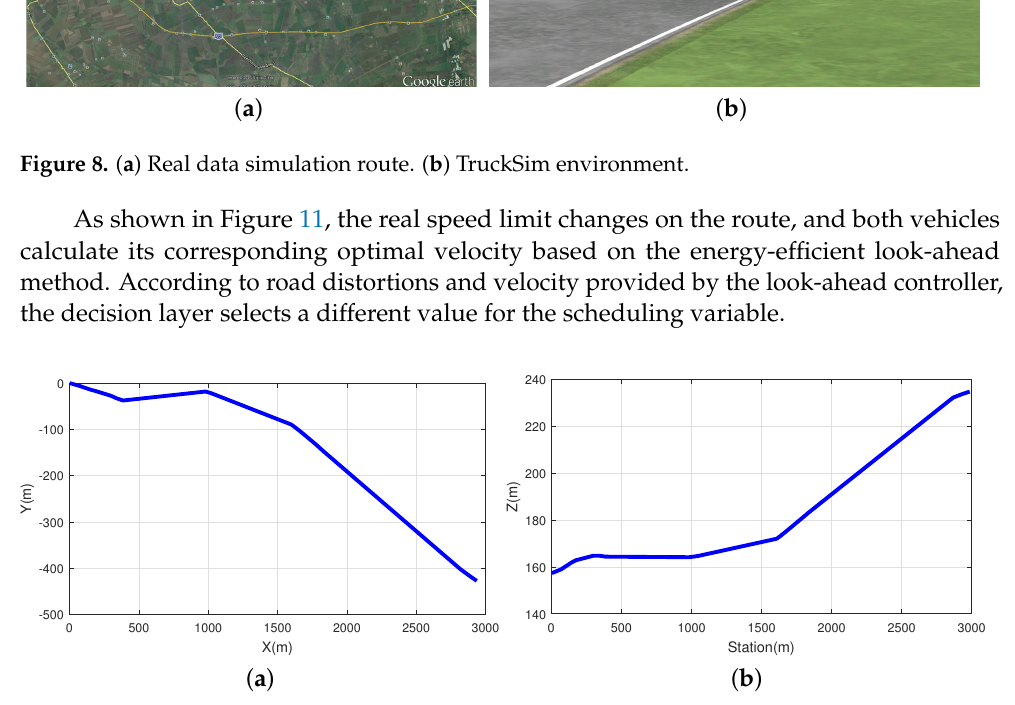
Figure 9. ( a ) X-Y geometry of the road section. ( b ) Station-Z geometry of the road